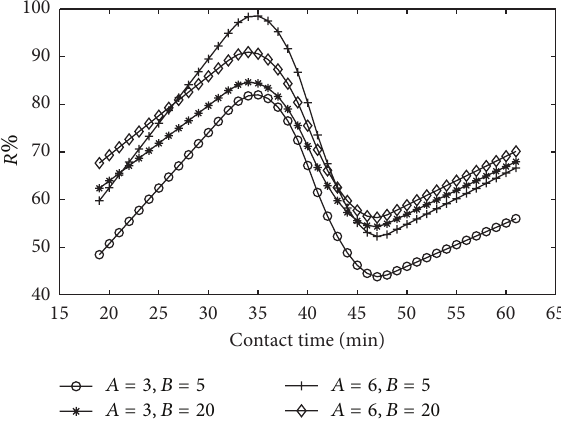
Figure 3: The effect of initial pH on Cu(II) removal.